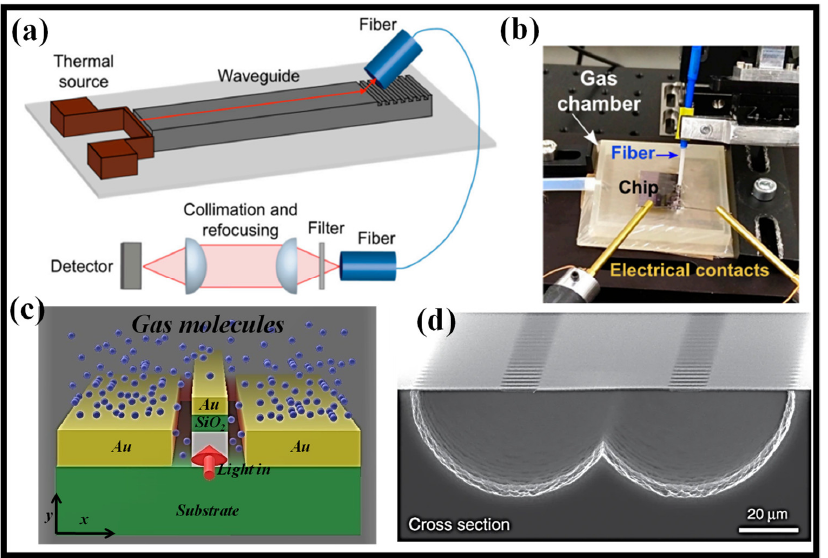
Figure 4. Recently proposed waveguide-based gas sensors, ( a ) schematic view of the gas sensor measuring setup [78], ( b ) experimental realization of the gas cell [78], ( c ) schematic of the polarization independent hybrid plasmonic waveguide for gas sensing [84], ( d ) SEM image of the suspended rib waveguide [86]. Toxic gas sensors based on integrated photonics are being actively researched. Sensors are described, in which the principle of operation is based on a change in the transmittance of the waveguide when the functional layer is exposed to the detected gas. SO 2 and H 2 S